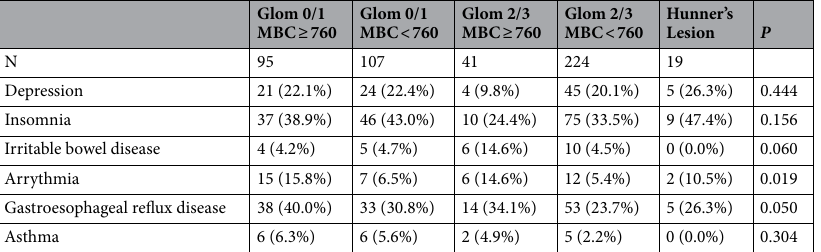
Table 4. Frequencies of various autonomic nervous system-related comorbidities, compared between the five patient subgroups. The data are presented as number (percentage). Glom, glomerulation grade; MBC, maximal bladder capacity